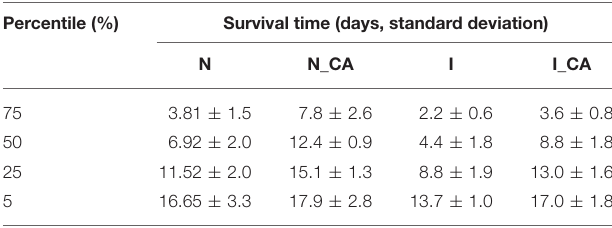
TABLE 1 | Percentiles of C. elegans lifespan for the various nematode groups considered in the study. Percentile